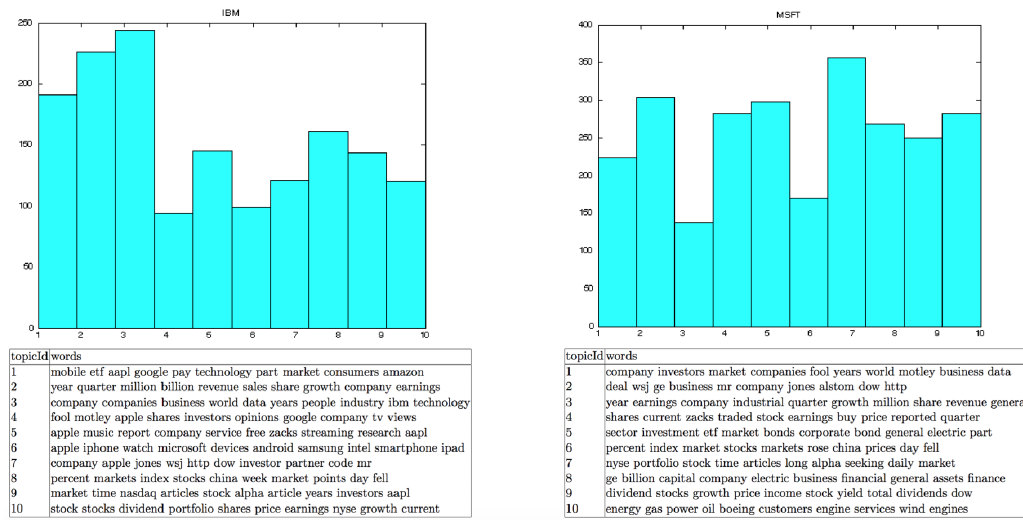
Figure 14. Topic modeling for IBM and MSFT stocks. The y -axis represents the number of texts in each topic, and the x -axis represents the topicId.